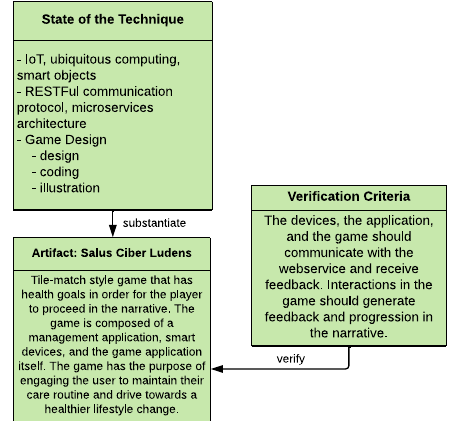
Figure 5. State of the Technique, artifact, and verification criteria.